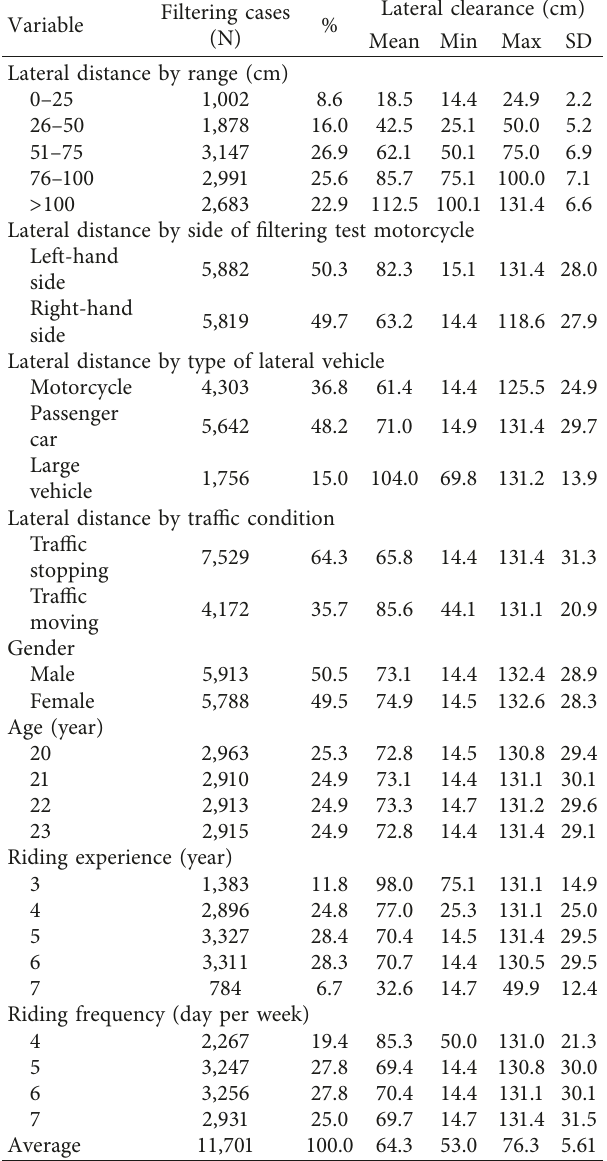
Table 6: Measurement results of lateral clearance. Table